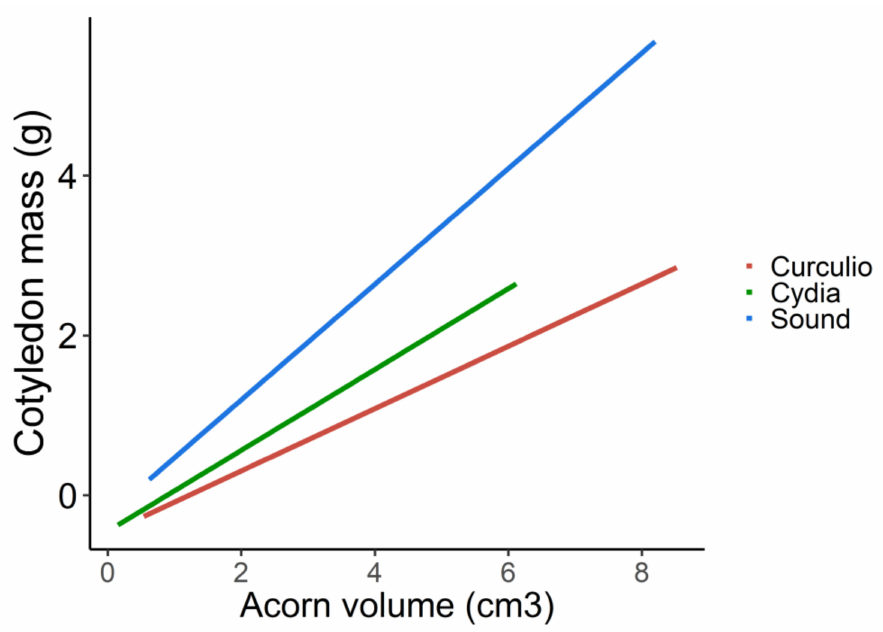
Figure 4. Relationship between acorn volume (cm 3 ) and cotyledon dry mass (g) in the different types of acorns. Blue, green and red lines correspond to sound acorns and those infested by Cydia and Curculio ,